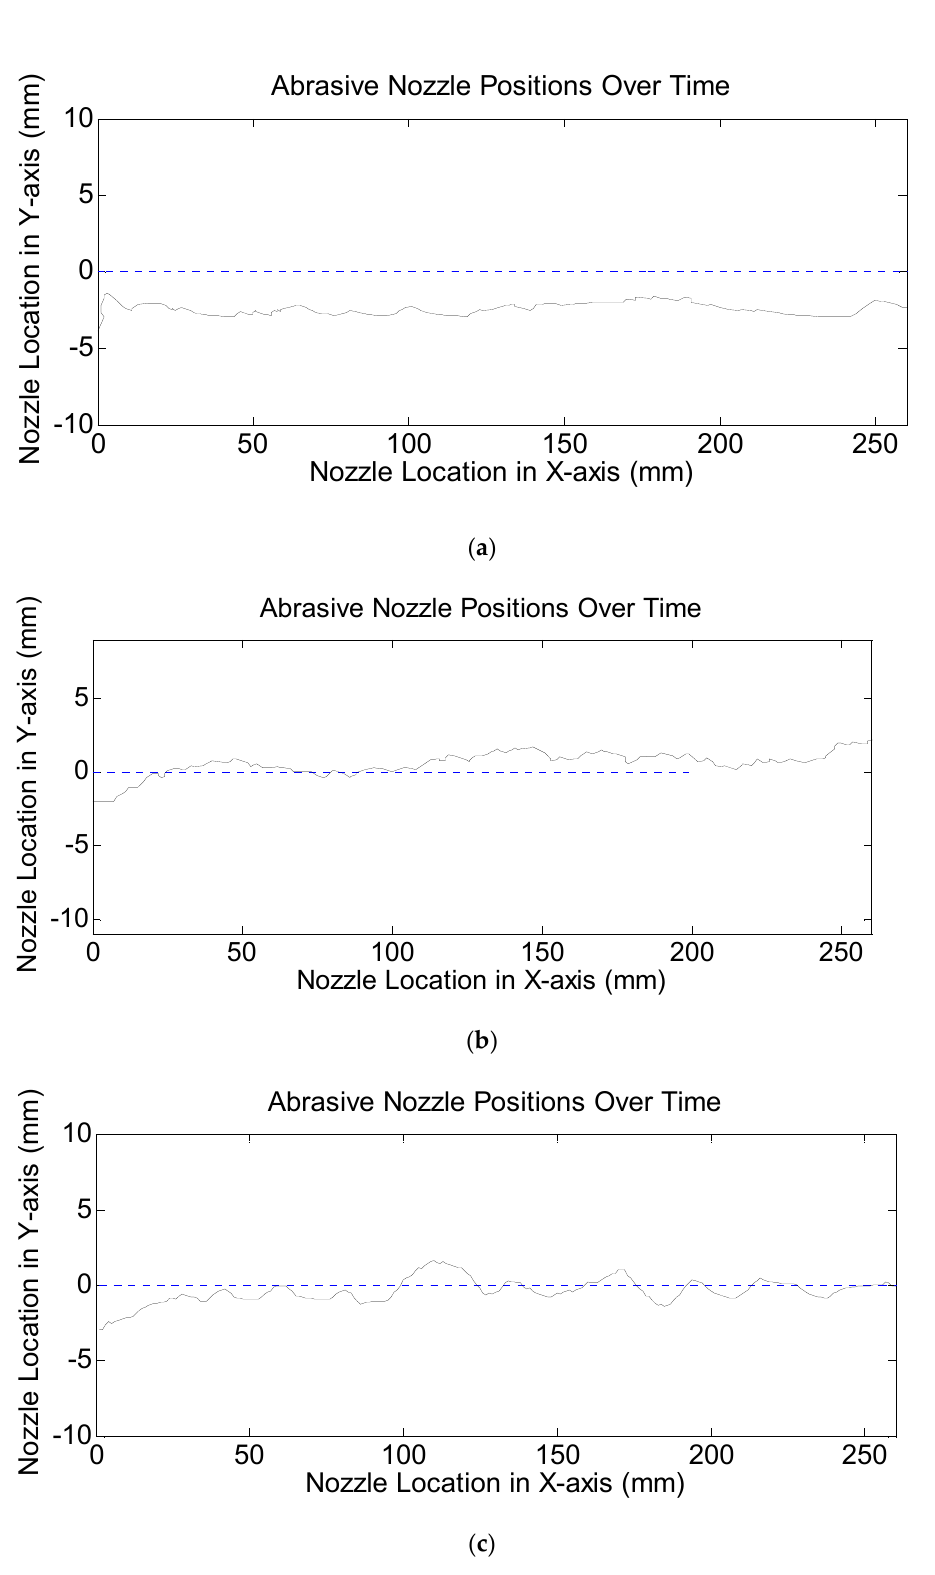
Figure 3. The nozzle position obtained from three participants performing the task using the conventional approach: ( a ) a participant who lacks accuracy ( b ) a participant who lacks precision ( c ) a participant who performs best but the positions still show the lack of both accuracy and precision.